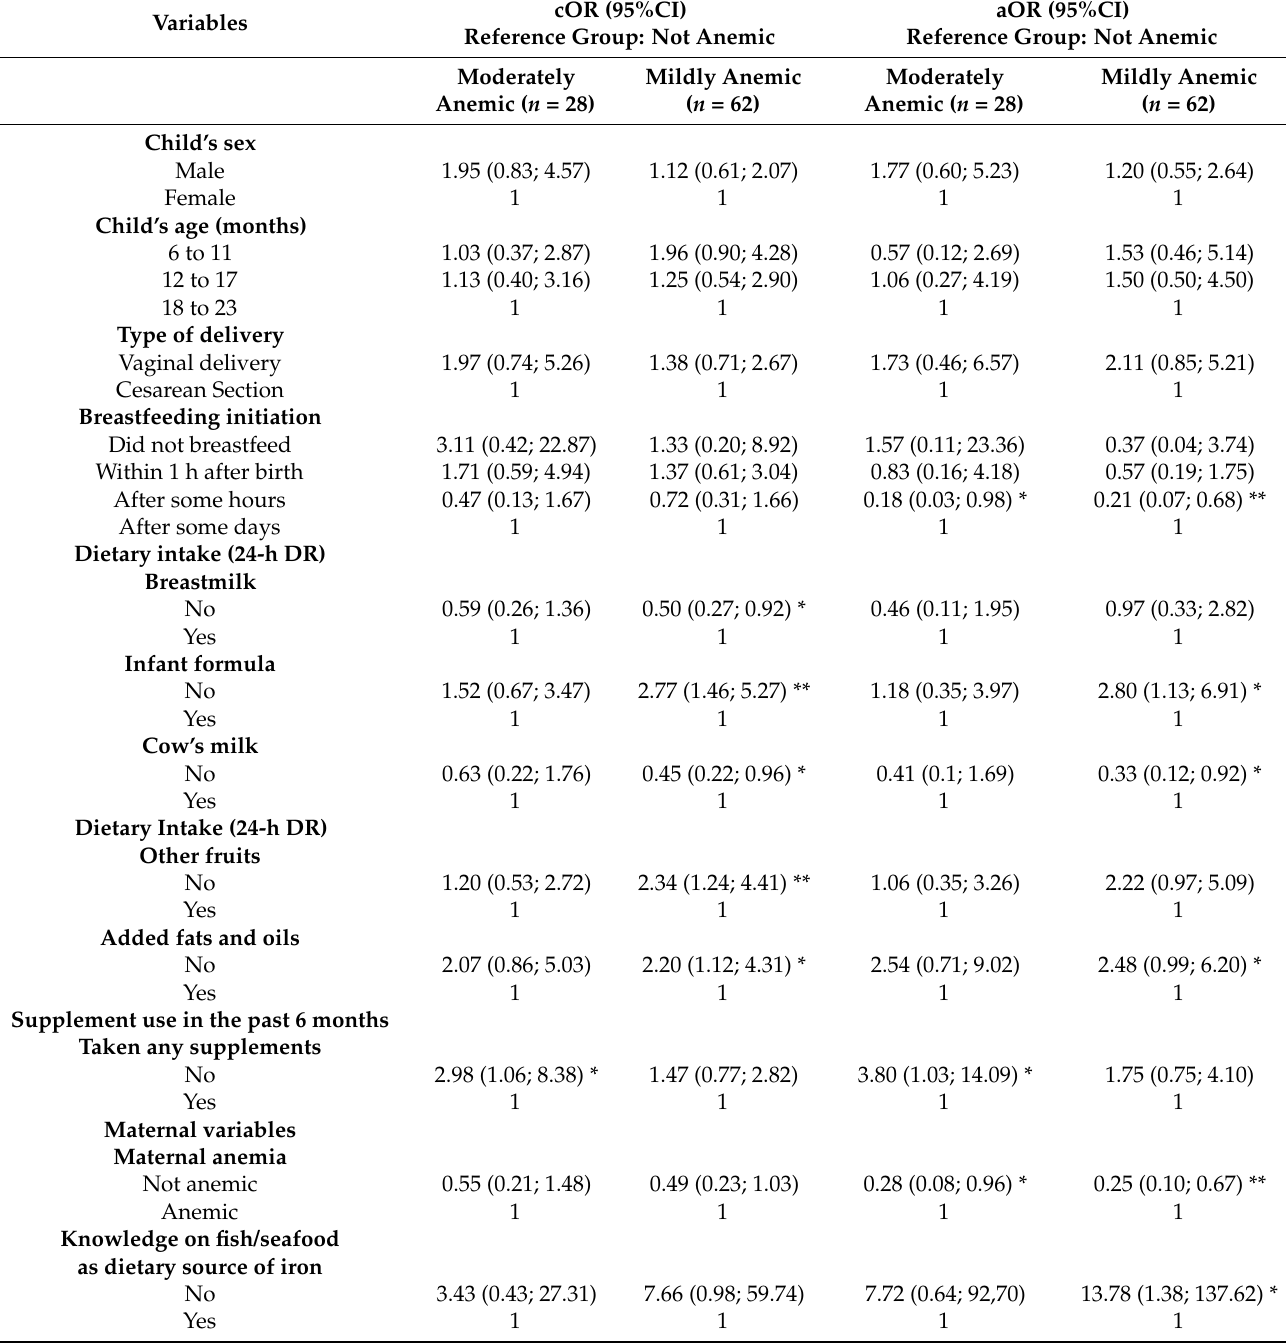
Table 7. Determinants of moderate and mild anemia of Syrian refugee children aged 6 to 23 months. Variables